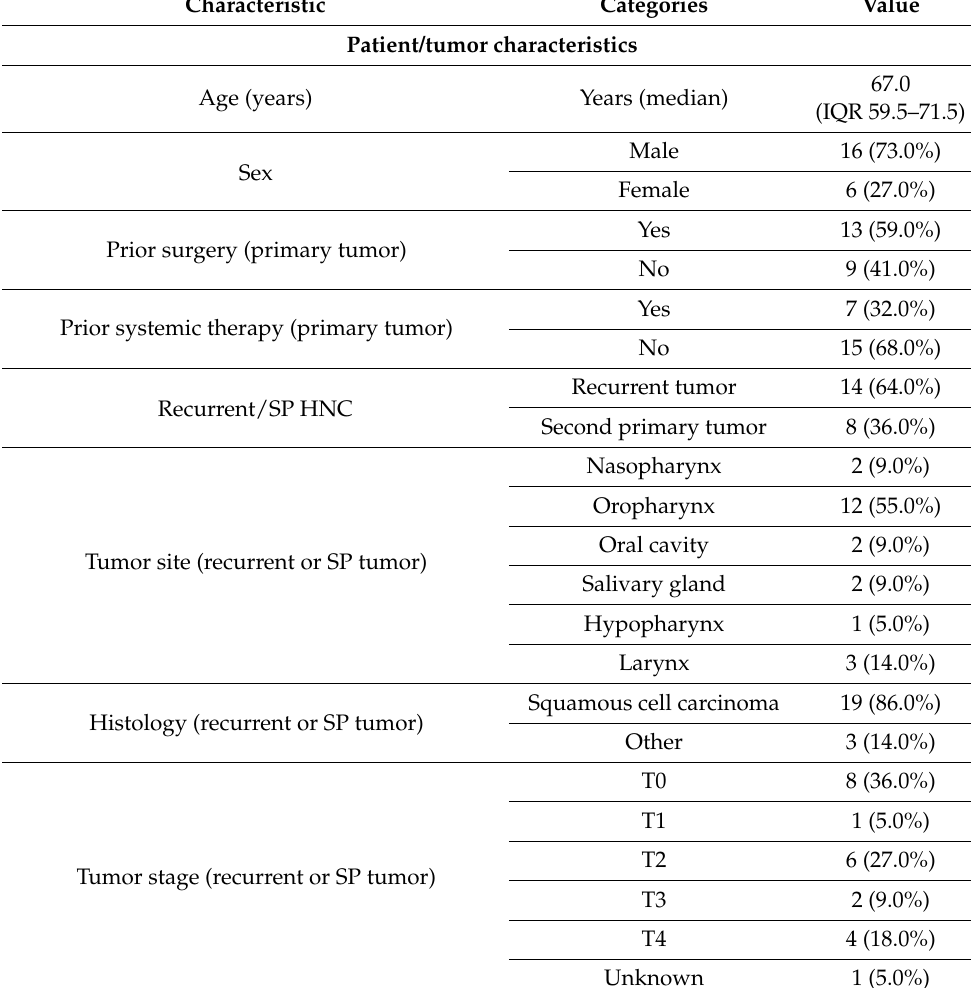
Table 1. General characteristics of patient tumor and